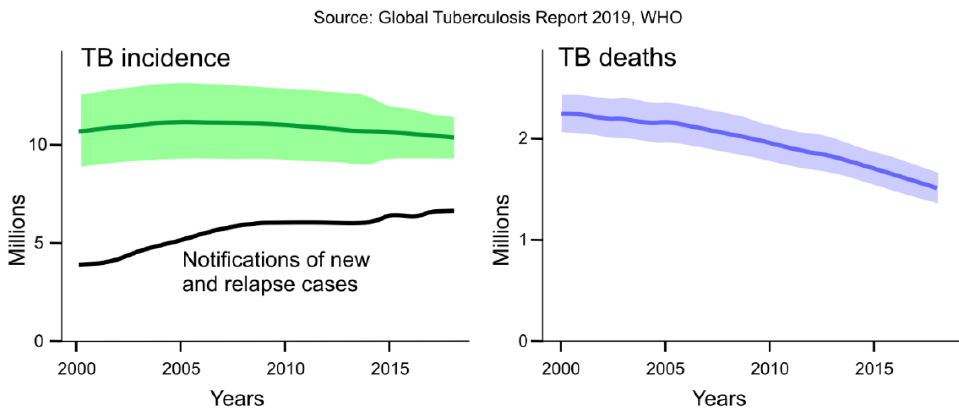
Figure 1. Global trends in the estimated number of incident tuberculosis (TB) cases with the new and relapse occurrences and the estimated number of deaths caused by TB, 2000–2018. (Shaded areas represent uncertainty intervals.)